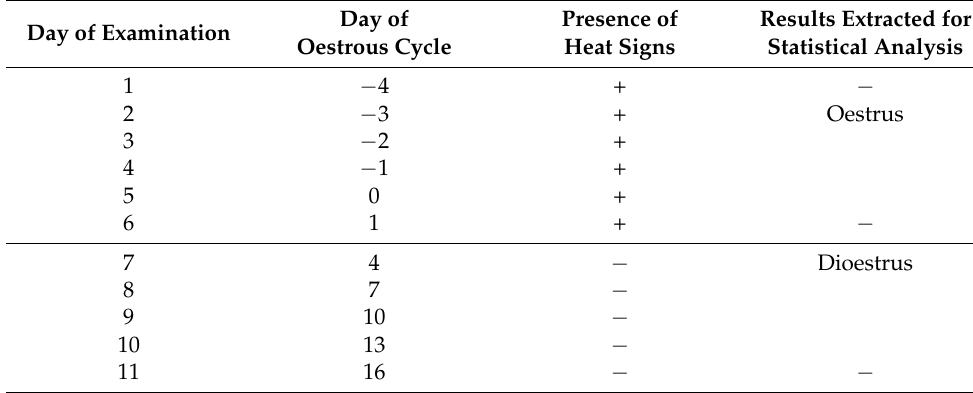
Table 1. The schedule of examining the